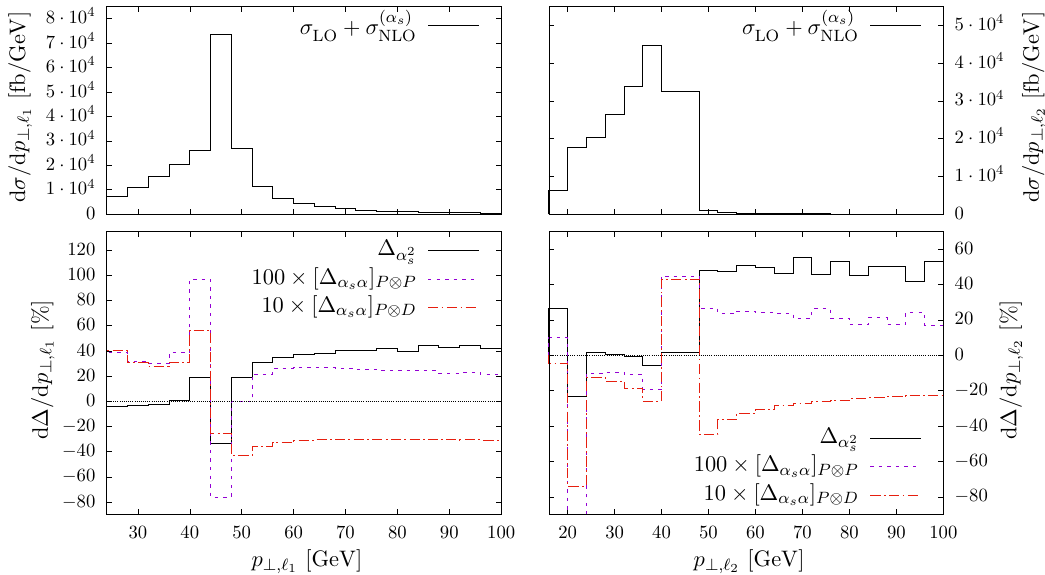
Figure 5. Relative di(cid:11)erential corrections (cid:1) for the transverse momentum of the leading (left) and subleading (right) lepton, p ? ;‘